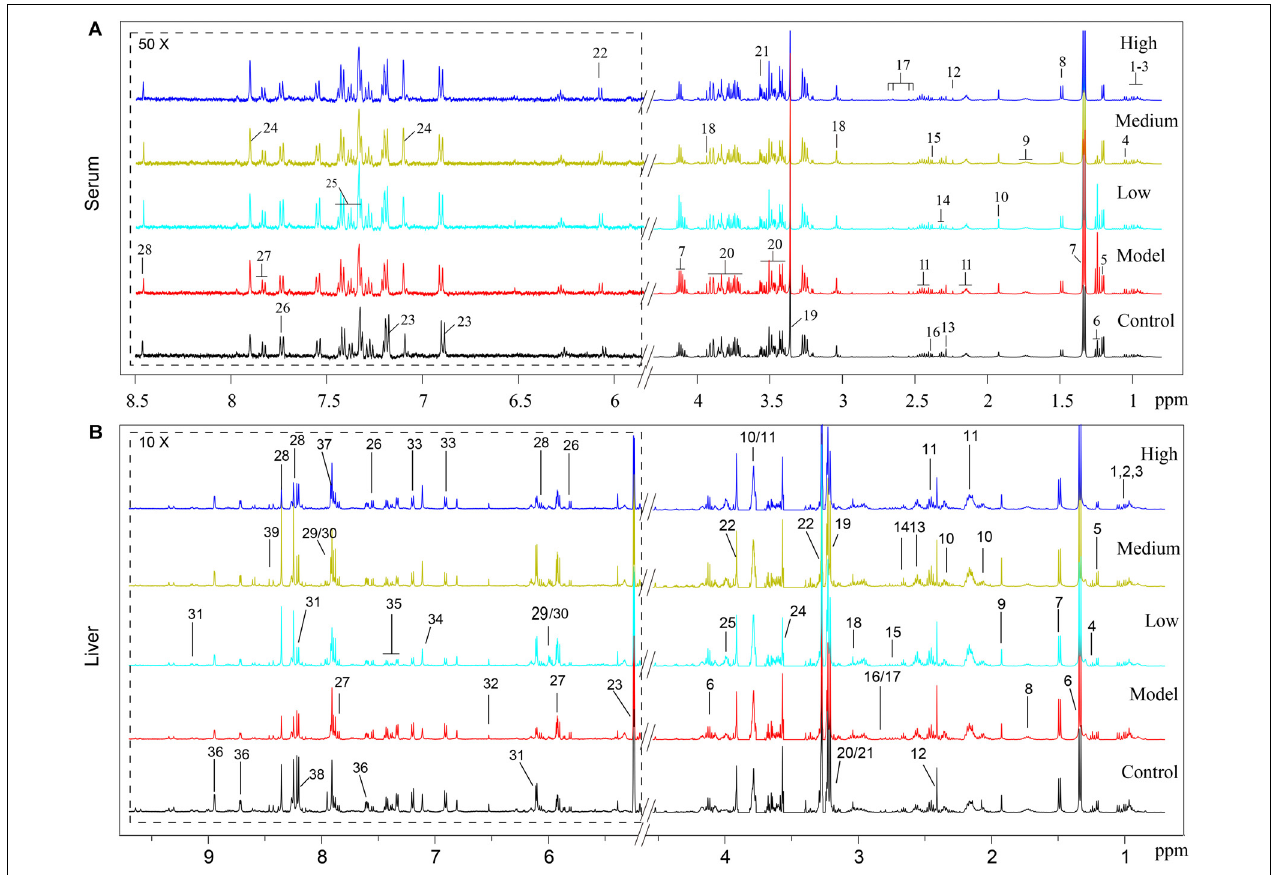
FIGURE 5 | (A) Typical 500 MHz 1 H NMR spectra of the serums from rats of control, model, and low, medium, and high dose of SWGNP treated groups: 1. isoleucine, 2. leucine, 3. valine, 4. 3-hydroxyisobutyrate, 5. 3-hydroxybutyrate, 6. ethanol, 7. lactate, 8. alanine, 9. lycine, 10. acetate, 11. glutamine, 12. acetone, 13. acetoacetate, 14. GABA, 15. pyruvate, 16. succinate, 17. citrate, 18. creatine, 19. methanol, 20. glucose, 21. glycine, 22. inosine, 23. tyrosine, 24. histamine, 25. phenylalanine, 26. tryptophan, 27. uridine, and 28. formate. (B) Typical 500 MHz 1 H NMR spectra of the liver extracts from control, model, and low, medium, and high dose of SWGNP-treated rats.1. Isoleucine, 2. leucine, 3. valine, 4. ethanol, 5. 3-hydroxybutyrate, 6. lactate, 7. alanine, 8. lysine, 9. acetate, 10. glutamate, 11. glutamine, 12. succinate, 13. glutathione, 14. 5,6-dihydrouracil, 15. aspartate, 16. dimethylamine, 17. sarcosine, 18. creatine, 19. choline, 20. phosphocholine, 21. sn -glycero-3-phosphocholine, 22. betaine, 23. glucose, 24. glycine, 25. phosphoethanolamine, 26. uracil, 27. uridine, 28. inosine, 29. UDP-glucose, 30. UDP-galactose, 31. NAD + , 32. fumarate, 33. tyrosine, 34. histidine, 35. phenylalanine, 36. niacinamide, 37. xanthine, 38. hypoxanthine, and 39.